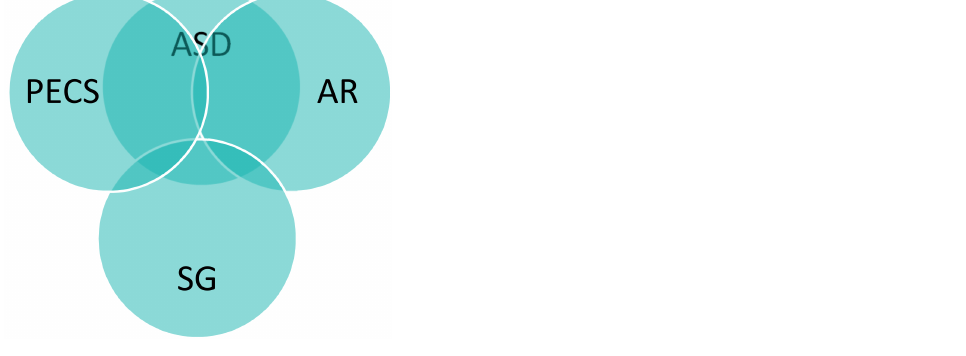
Figure 8. Overlapping domains of ASD patient rehabilitation, augmented reality environment, serious games, and PECS